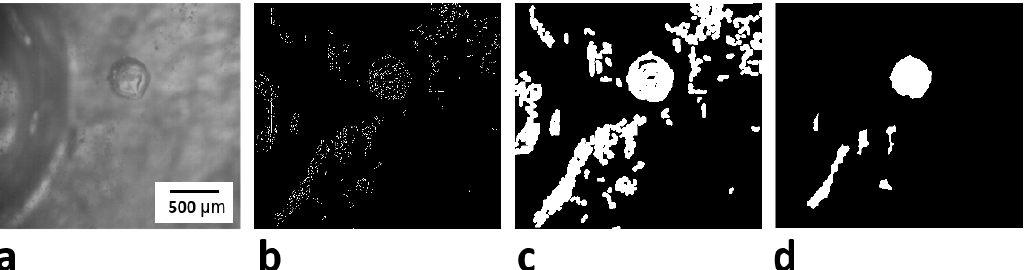
Figure 6. ( a ) HT-CSLM microscopy image of the silica inclusion suspended in the slag at a temperature of 1550.4 ◦ C and time 467.81 s. ( b ) Image of the inclusion after running the Canny edge detection method on Figure 3a. ( c ) Dilated image of the inclusion, which was segmented by edge detection. ( d ) Morphologically constructed inclusion after a sequence of erosion and hole-filling operation on MATLAB.